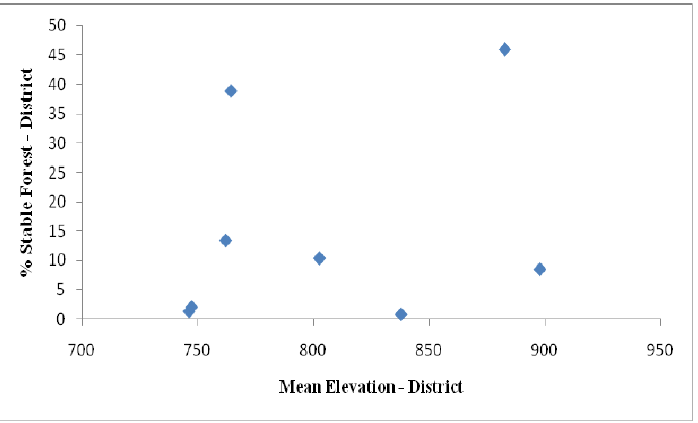
Figure 8a. Relationship between mean elevation and the distribution of stable forest for districts.